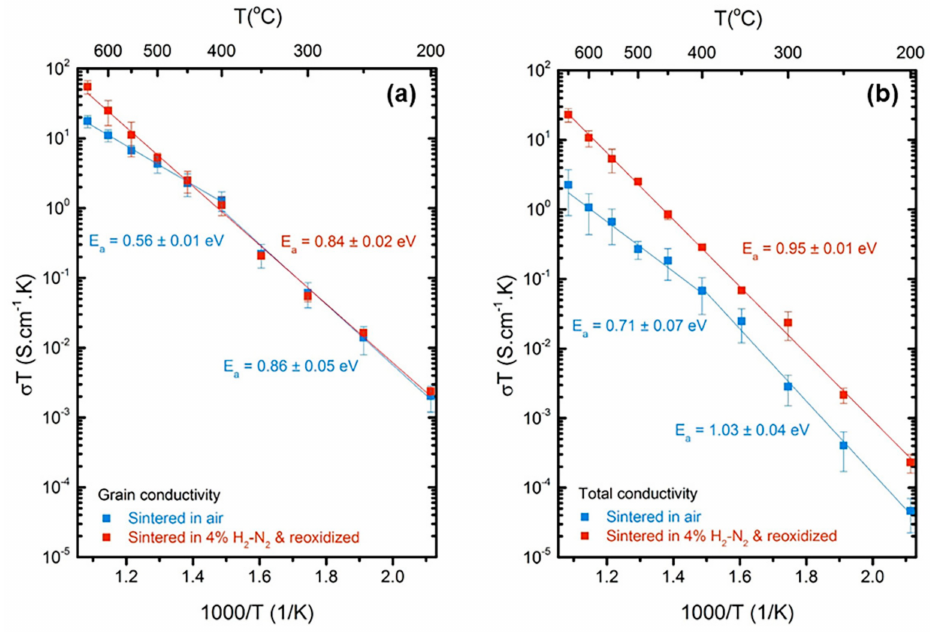
Figure 5. Arrhenius type plot of ( a ) grain conductivity and ( b ) total conductivity with respect to temperature for the 10GDC control and 4% H 2 balanced in N 2 sintered-reoxidized